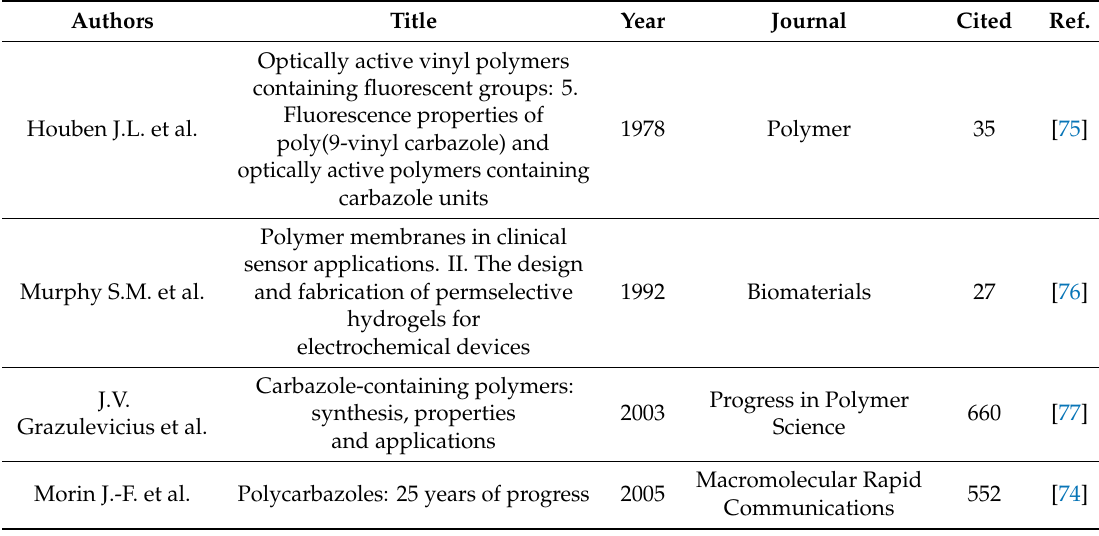
Table 1. Summary of the reviews on poly(carbazole)derivatives extracted from Scopus.